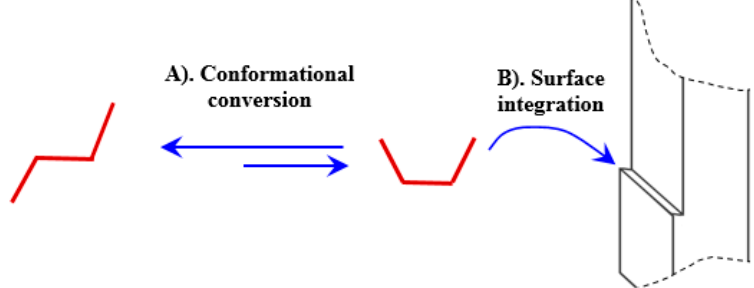
Figure 2. Two main steps occurring during crystal growth from solutions containing atropisomers.